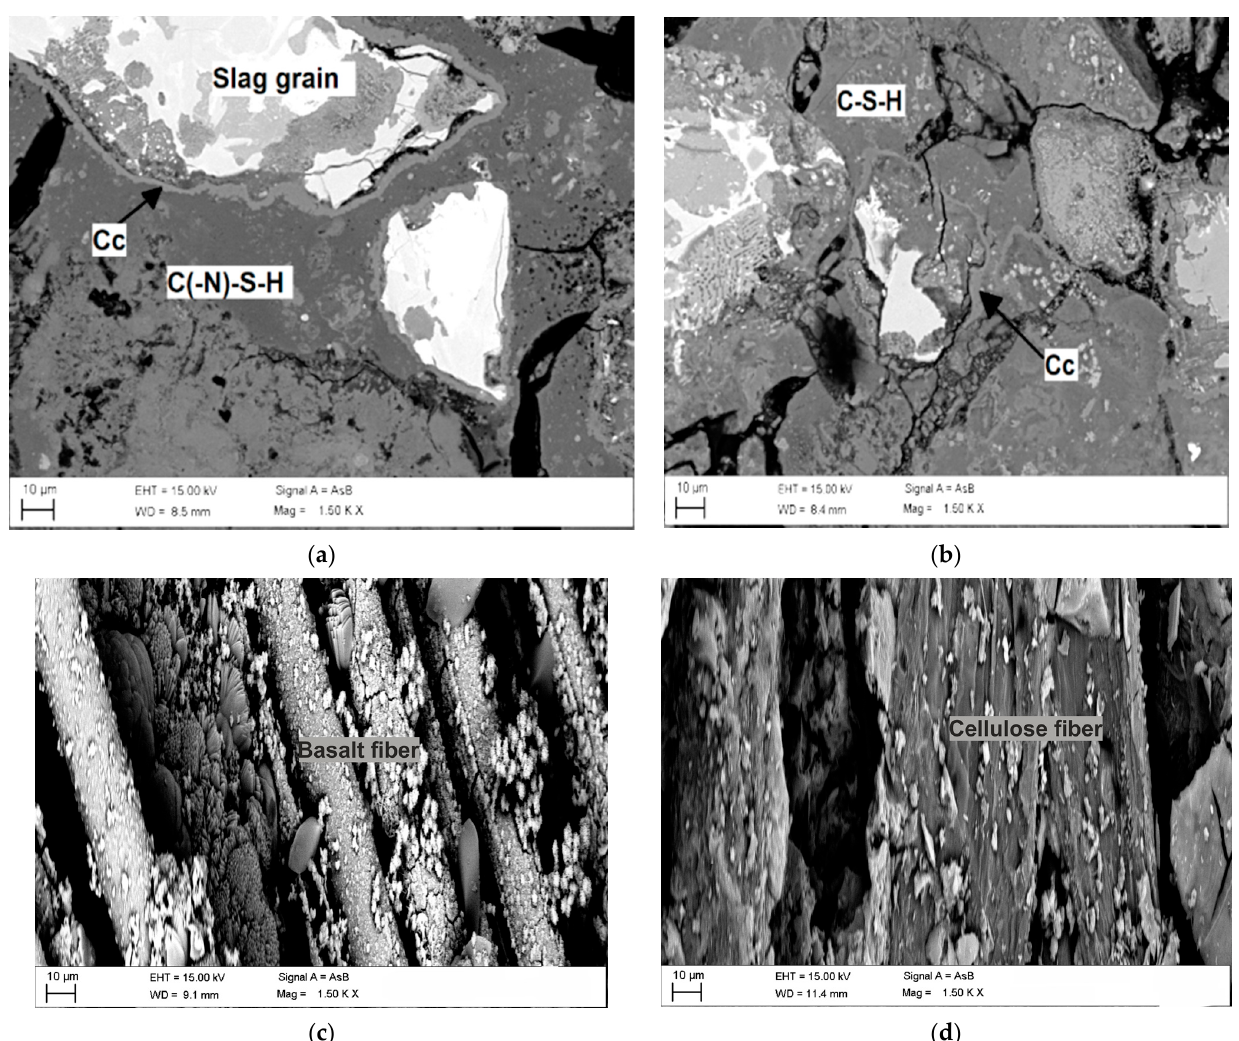
Figure 12. XRD pattern of AAM (a) and AAM after HCl (b): ( A ) M1 ( B ) M2 and ( C ) M3 (Q = quartz; C = calcite; P = portlandite).